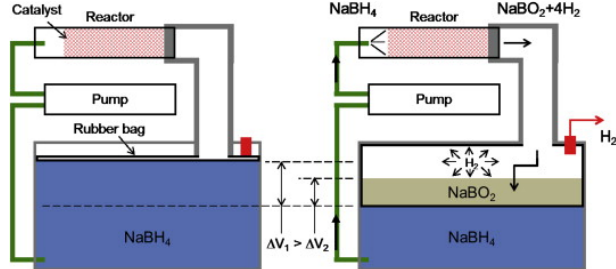
Figure 6. Schematic of a volume-exchange fuel tank. Reprinted with permission from reference [100]. Copyright 2014 Elsevier.